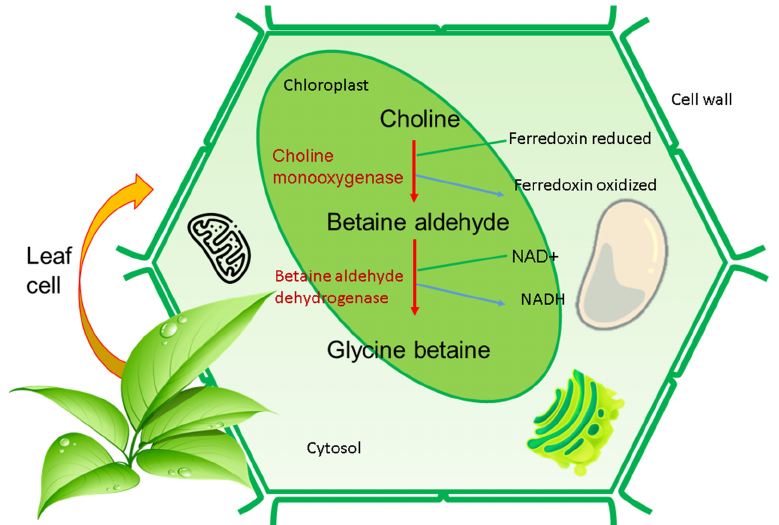
Figure 1. Biosynthesis of GB in plant cells (Figure adapted from Sakamoto and Murata [24]; Ashraf and Foolad [31]). and Foolad